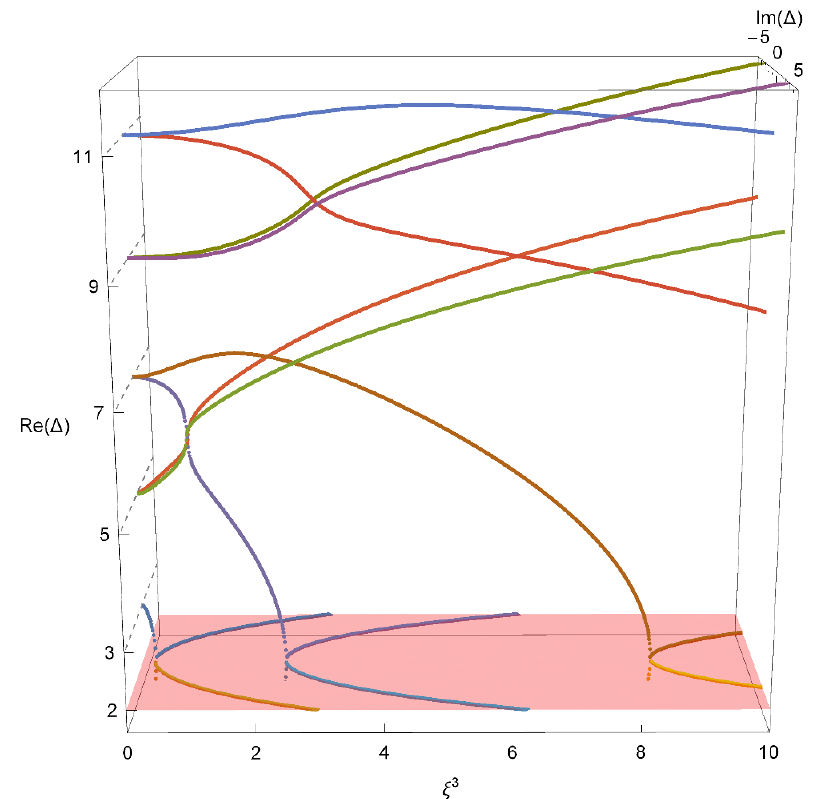
Figure 8 . Real and imaginary part of the scaling dimension of the nine lowest lying states with J = 3. The curve that starts at (cid:1)(0) = 3 corresponds to the operator tr( (cid:30) 3 that start at (cid:1)(0) = 3 + 2 k with k = 1 ; 2 ; 3 ; 4 correspond to the operators of the form (1.2) (or rather to their linear combinations diagonalizing the dilatation